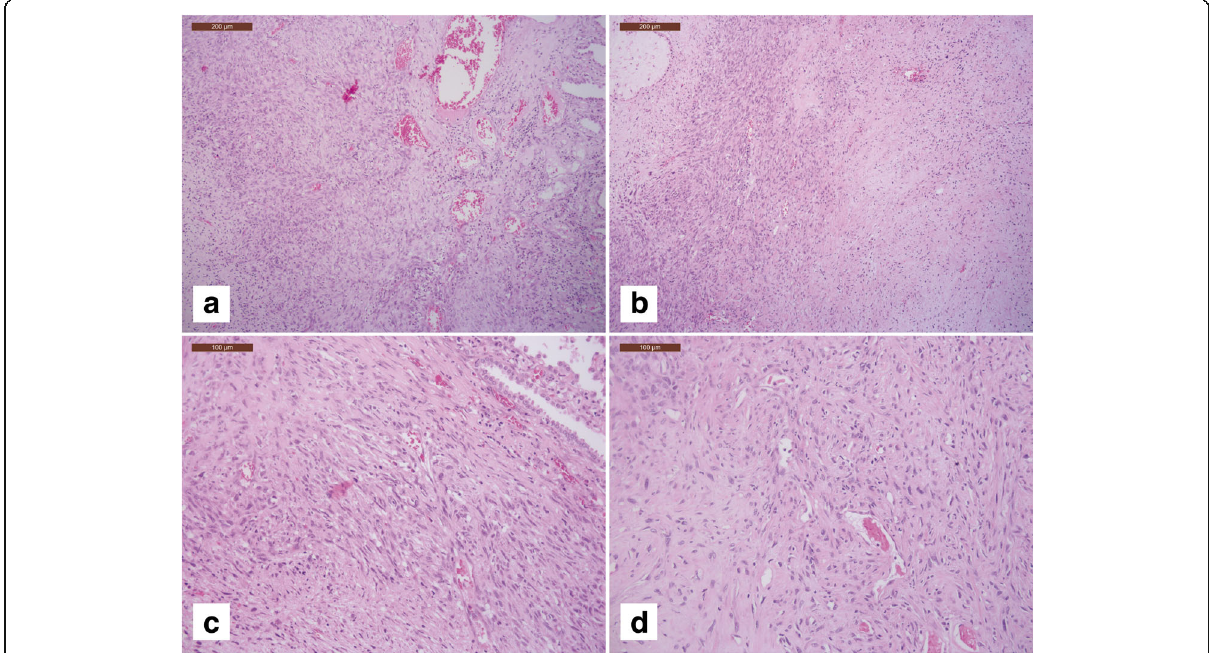
Fig. 2 a , b Panoramic view of the pulmonary lesion showing uniform spindle cells arranged in a fascicular pattern; alveolar epithelium is focally entrapped by the neoplastic cells (H&E, 100×); c , d some small thinwalled blood vessels resembling spiral arterioles of late secretory endometrium were unevenly distributed among the stroma (H&E, 100×); b , d , neoplastic cells show moderate atypia and foci of hyaline-type necrosis, in a background of fibromyxoid stroma); d , the tumor cells had oval to plump spindle-shaped nuclei with finely granular chromatins, inconspicuous nucleoli, and